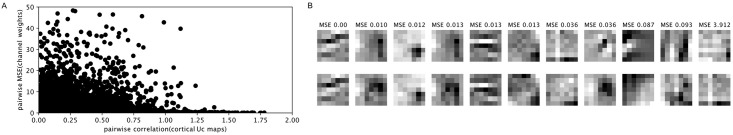
Relation between channel similarity and Uc map similarity.A. Relation between channel similarity and Uc map similarity in V1. Correlations are corrected with a fisher z-transform, and correlation signs are omitted. Highly similar Uc maps (high correlations) only occur for highly similar (small MSE) channels. However channels similar under MSE do not imply a highly similar Uc map. B. Examples of mean-squared error as a channel similarity measure.